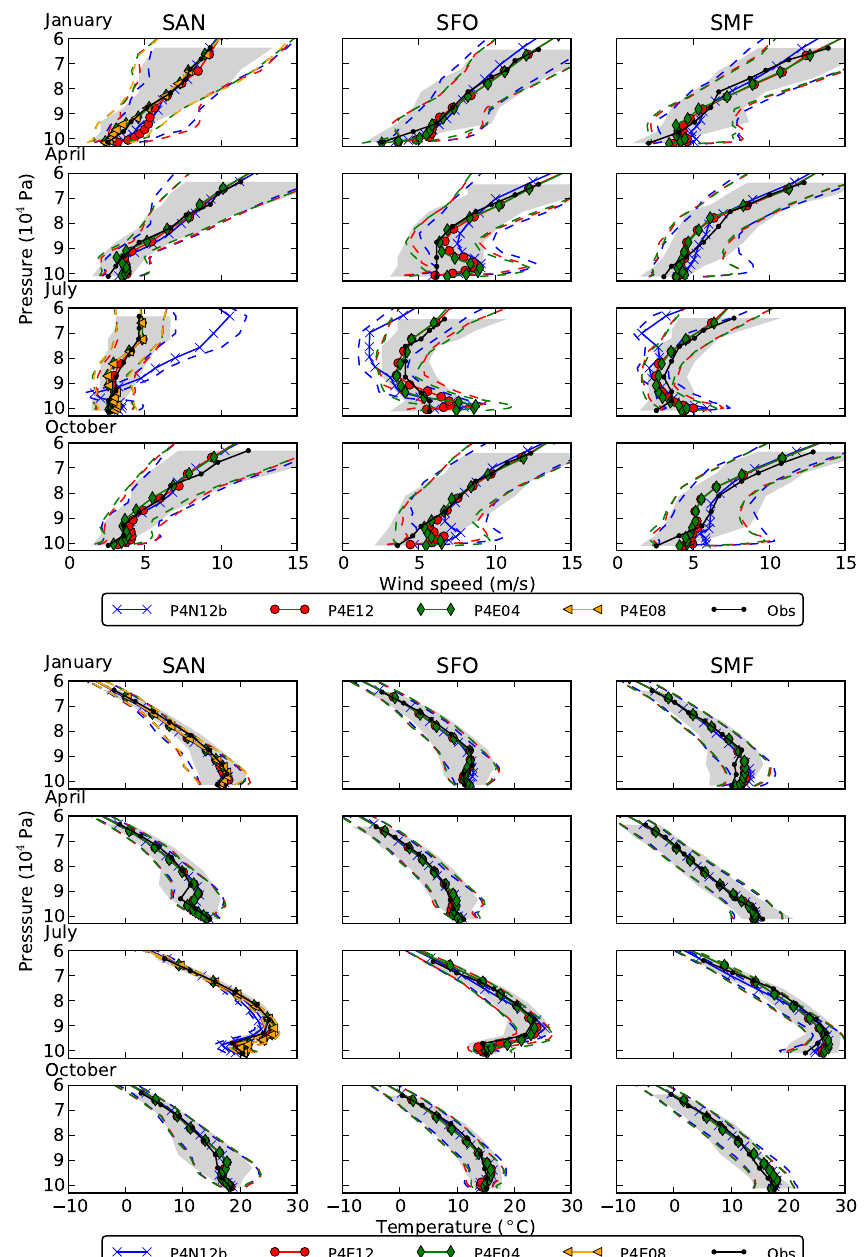
Fig. 7. Vertical profile of the monthly median wind speed and temperature at SAN, SFO and SMF for January, April, July and October 2009 in simulations varying the boundary conditions and nesting options. The grey envelope represents the upper and lower quartiles of the observations. The dotted lines show the upper and lower quartiles for each simulation. The profiles go from ground to around 4km.